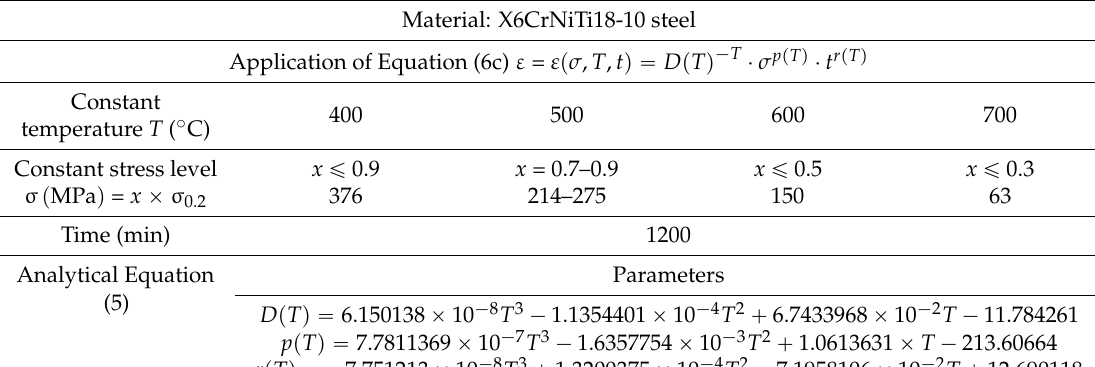
Figure 9. Experimental and modeled creep curves: steel X6CrNiTi18-10. Modeling was performed using Equation (5) by applying the principle 6c.